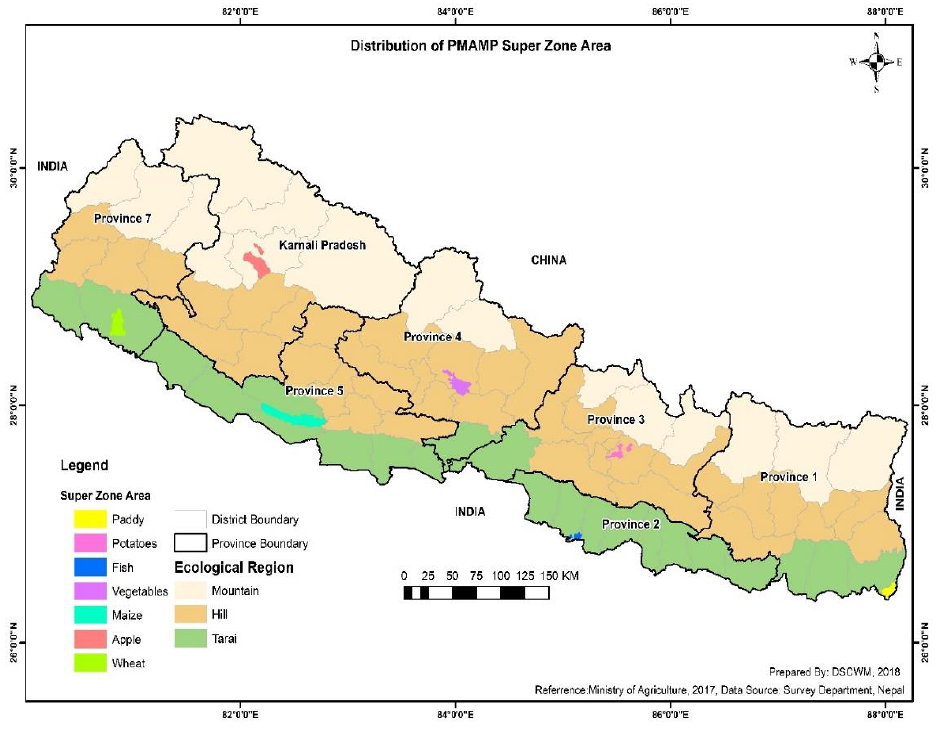
Figure 1. SDP areas of